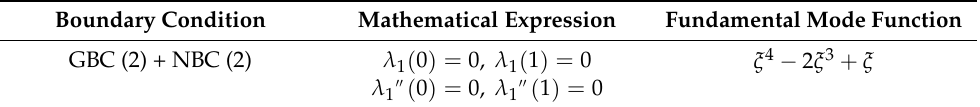
Table 5. Simple-simple fundamental mode function ( λ 1